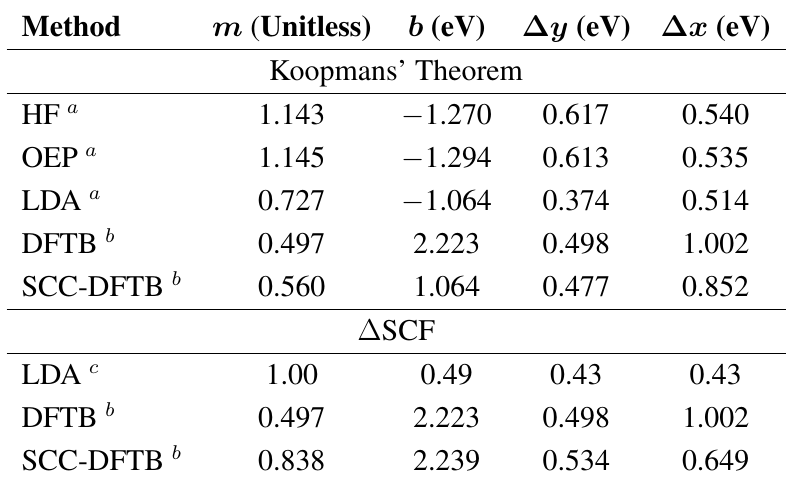
Table 4. Fitting data for first IPs [40]: y = mx + b , where x is the experimental IP and y is the theoretical IP, both in eV. HF, Hartree–Fock; OEP, optimized effective potential; LDA, local density approximation; DFTB, density-functional tight binding (without self-consistent charge); SCC-DFTB, self-consistent charge